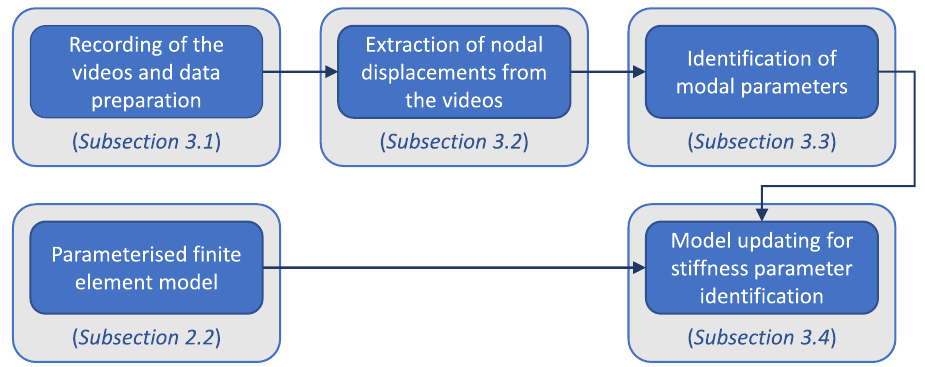
Figure 4. Flowchart of the investigated